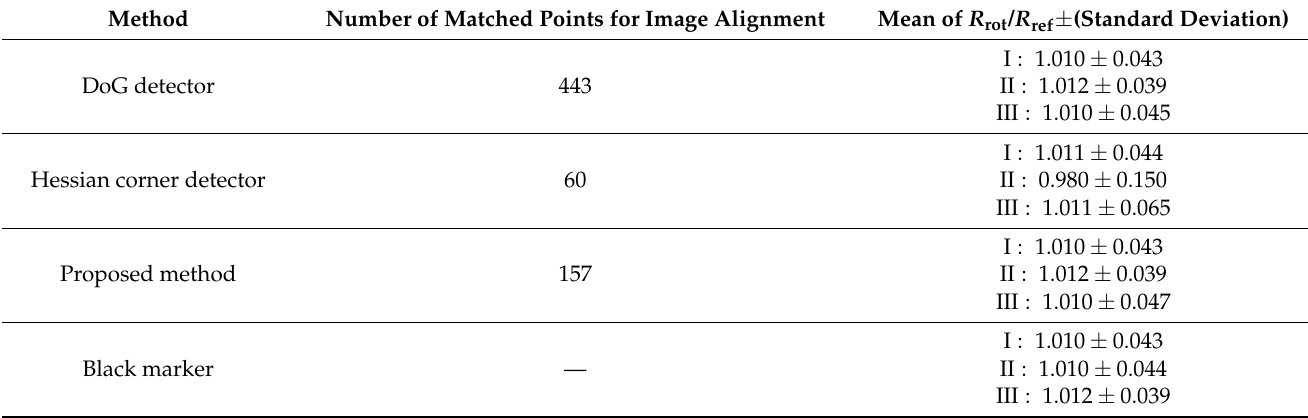
Figure 3. Ratio of image ratios, 𝑅 rot /𝑅 ref , for aligned images by ( a ) the DoG detector, ( b ) the Hessian corner detector, ( c ) the proposed method, and ( d ) the conventional method using black markers. ( e ) Processing area for Table 1. Table 1. Results of image alignment by each